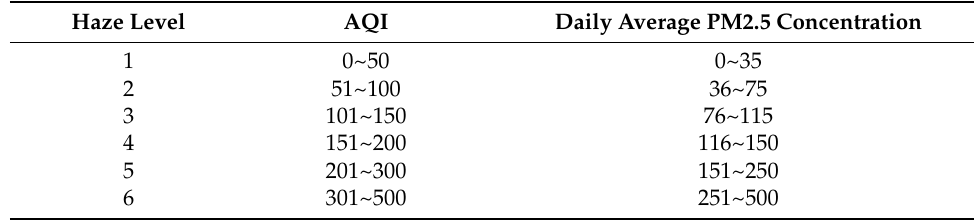
Table 3. Correspondence table among haze level, air quality index, and PM2.5 concentration.